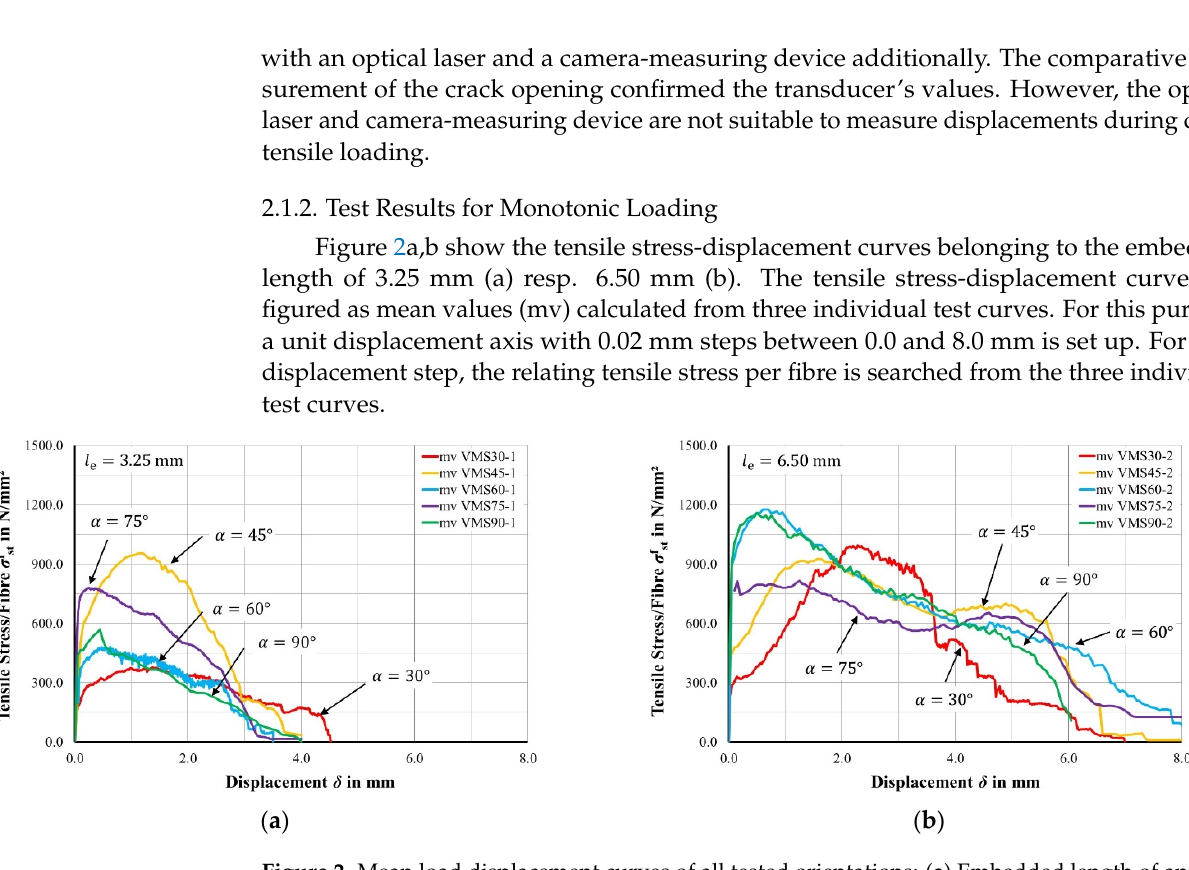
Figure 2. Mean load displacement curves of all tested orientations: ( a ) Embedded length of approximately 3.25 mm and ( b ) embedded length of approximately 6.50 mm.